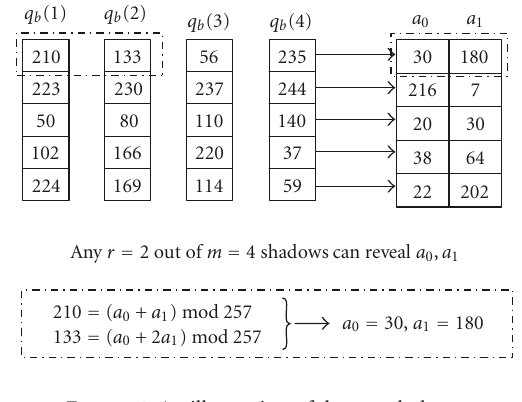
Figure 4: An illustration of the reveal